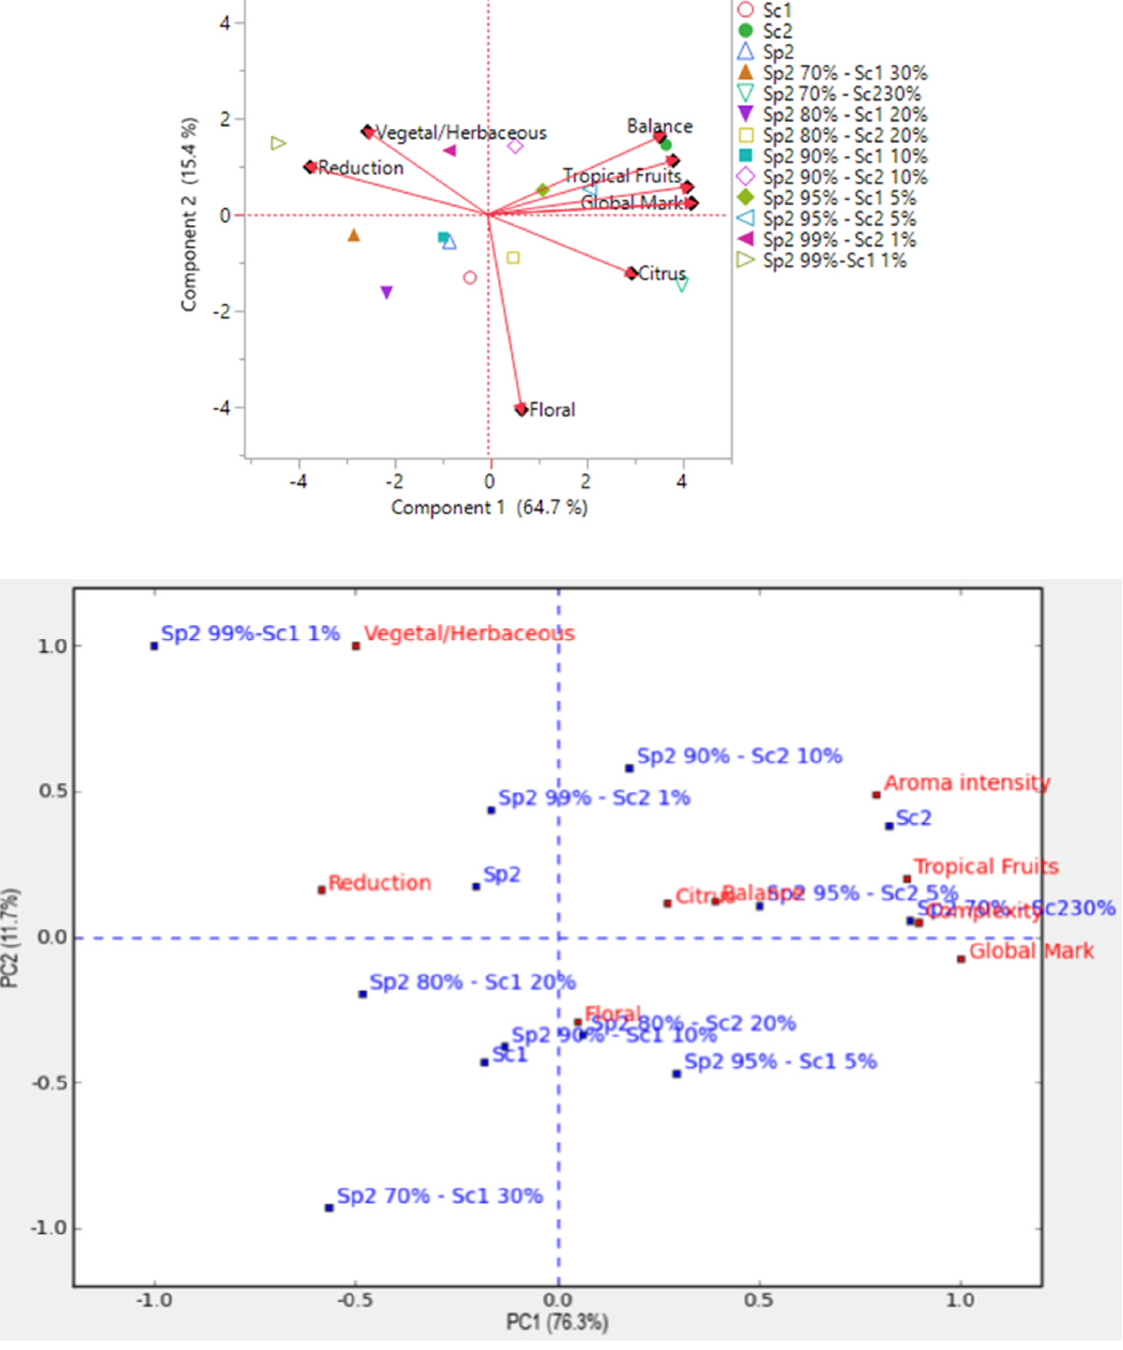
Figure 4. Biplot of the principal component analysis (PC1 vs. PC2) for descriptive sensory analysis of Sauvignon blanc wines fermented with monocultures of S. cerevisiae and S. pastorianus (Sc1, Sc2 and Sp2) as well as with mixed cultures of both species in different inoculation ratio.